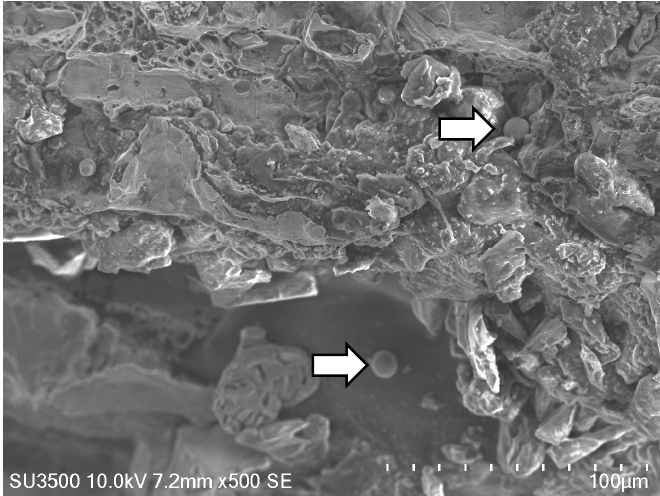
Figure 12. The presence of less dominant large precipitate.